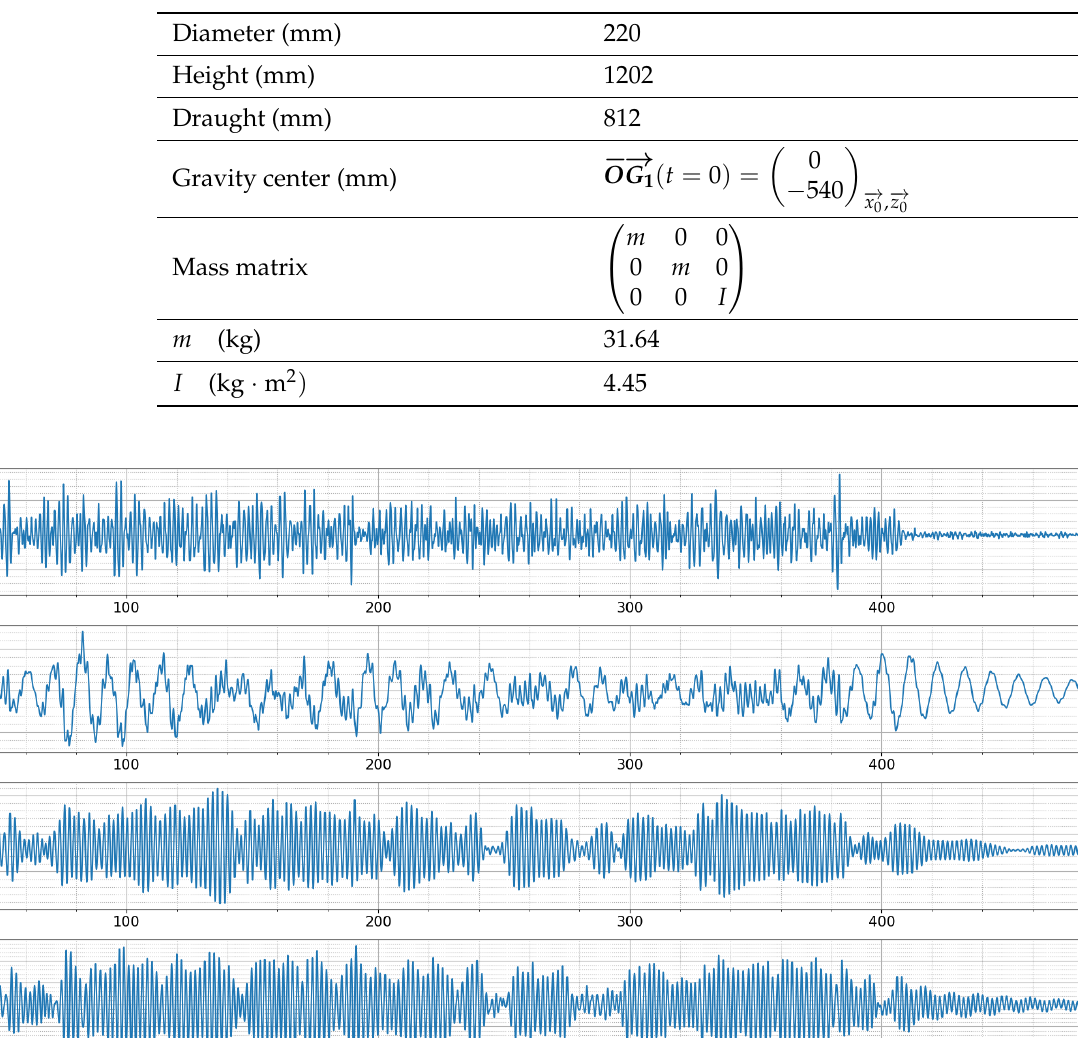
Table 2. Experimental cylinder characteristics.